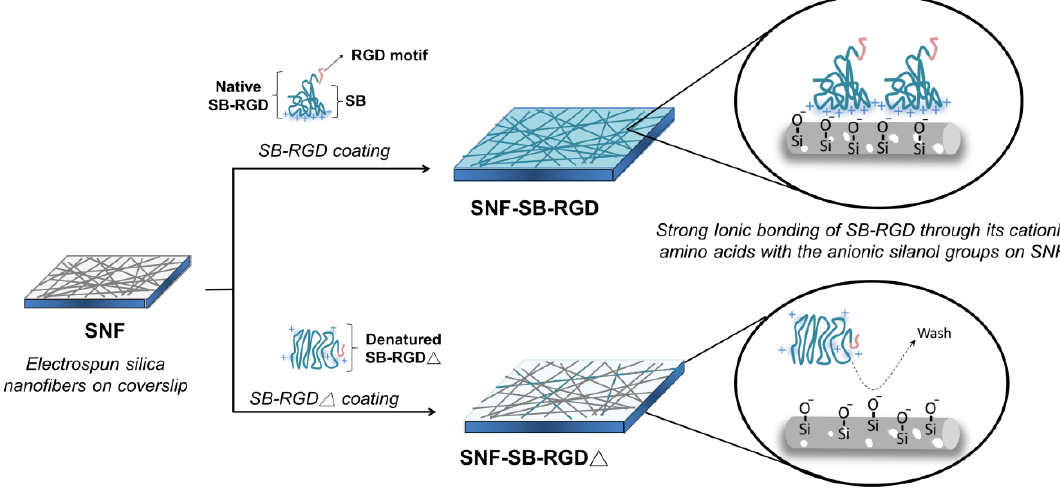
Figure 1. Schematic of the various prepared substrates. SNF: the uncoated mesoporous electrospun silica nanofiber on a coverslip. SNF-SB-RGD: the SNF substrate coated with purified native SB-RGD fusion protein that strongly bound to SNF surface through ionic bonding. SNF-SB-RGD ∆ : SNF substrate coated with SB-RGD ∆ , which yielded limited binding after PBS washing due to denatured conformation.